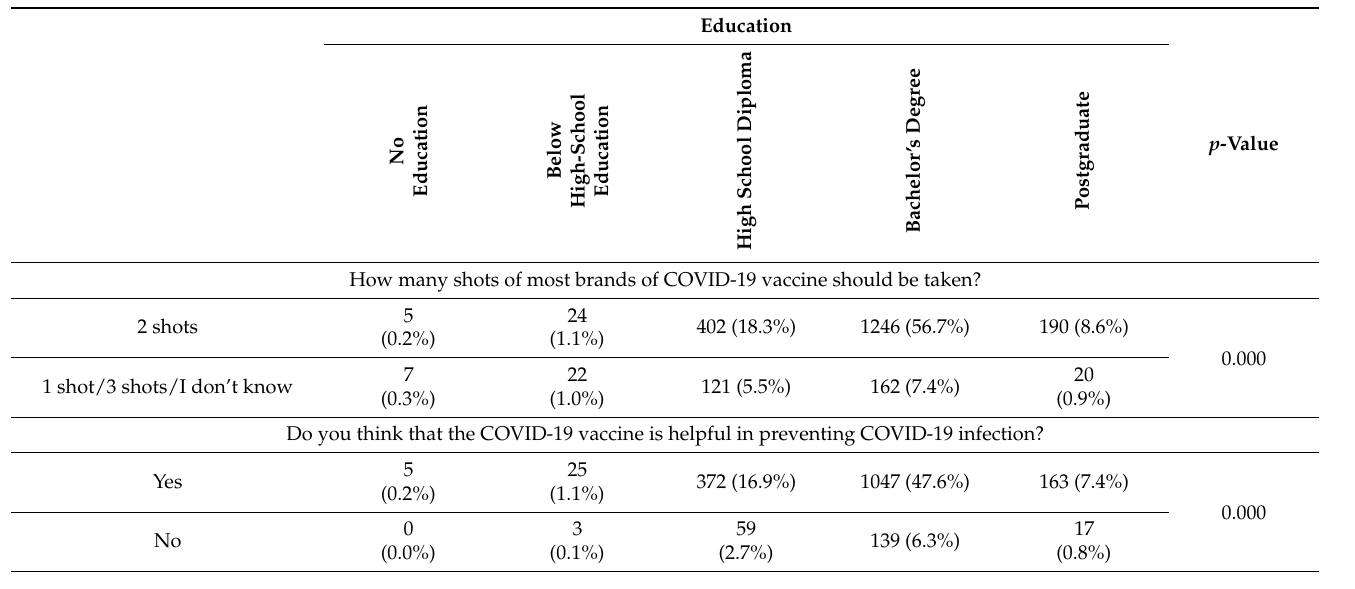
Table 8. The relation between knowledge and